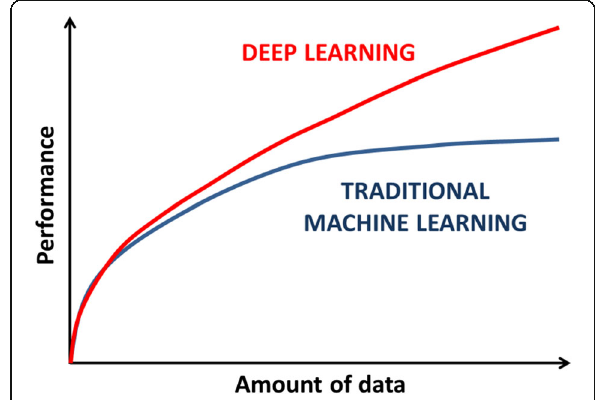
Fig. 3 Graphical representation of the different relationship between the amount of data given to traditional ML or DL systems and their performance. Only DL systems continue to increase their